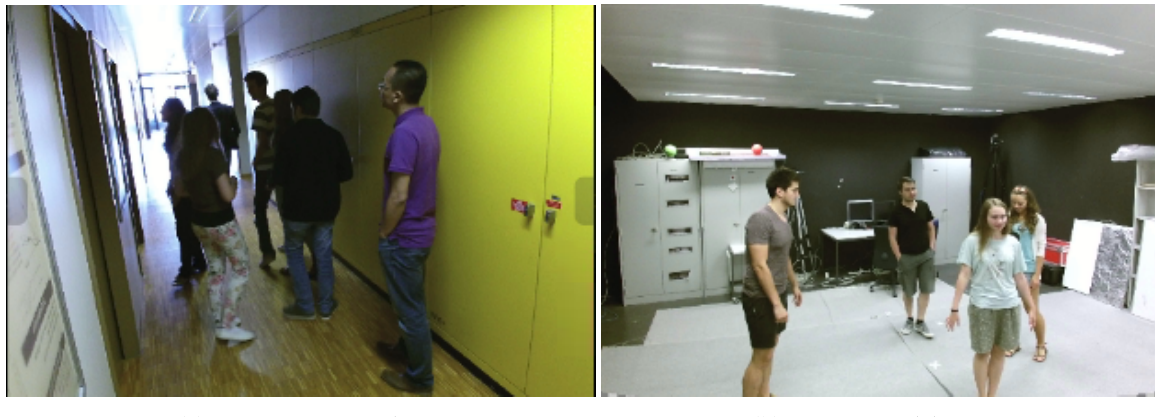
Figure 10. Different scenarios of the EPFL